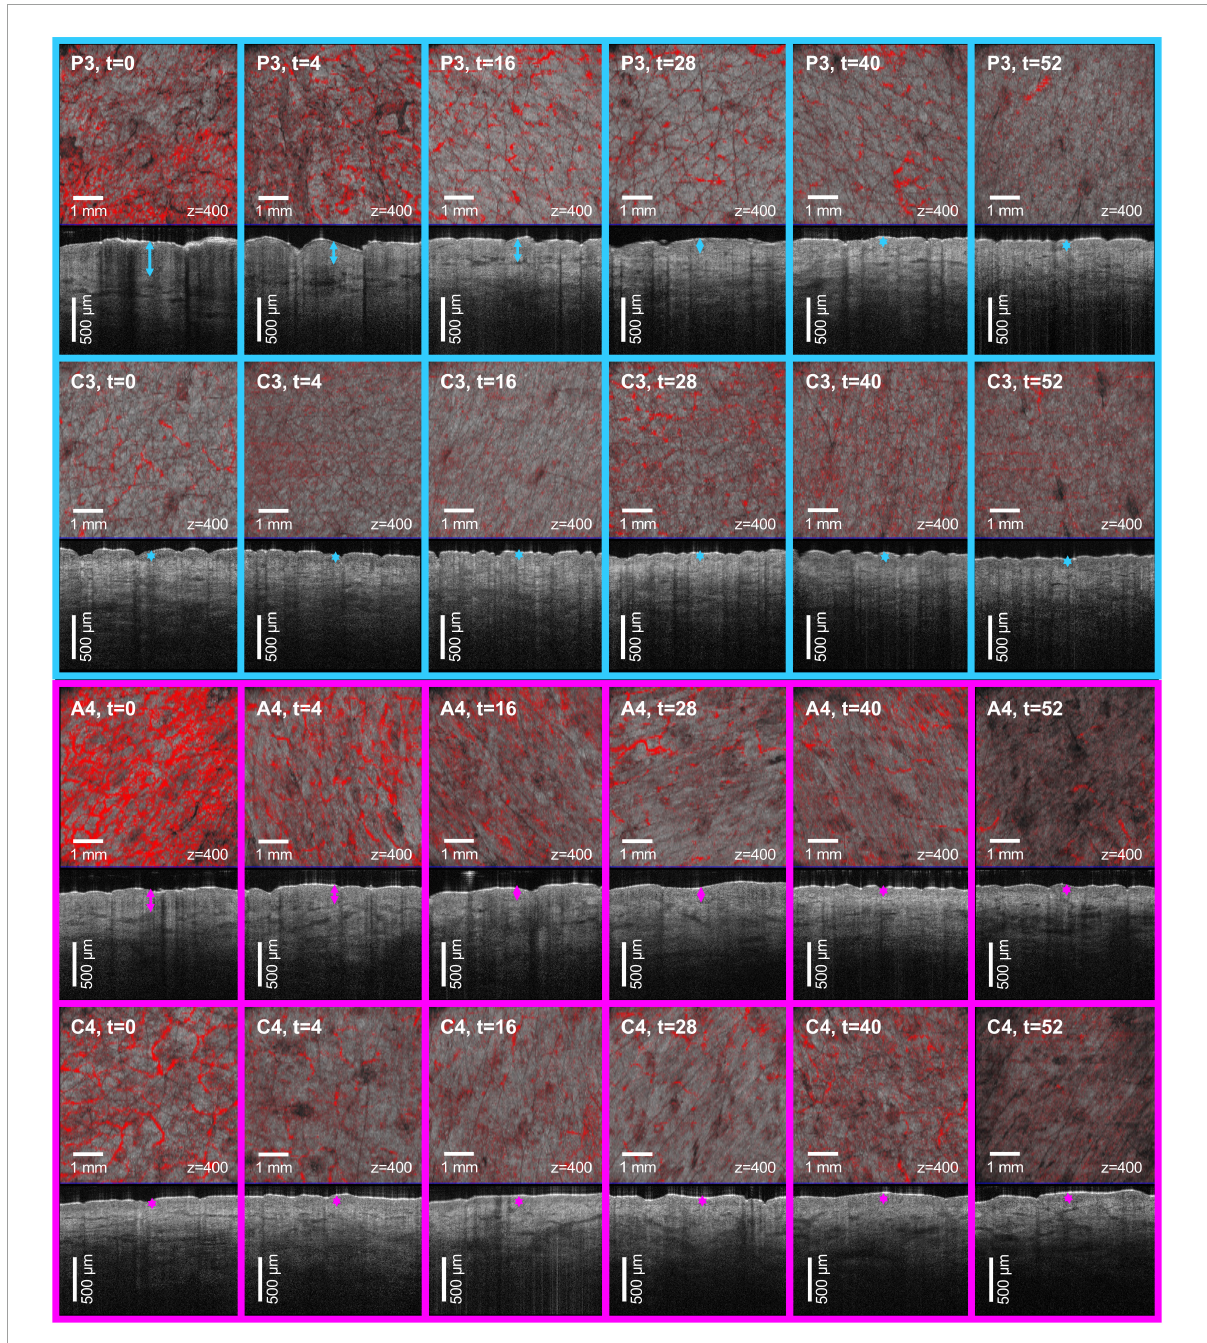
FIGURE3 Optical coherence tomography (OCT) guided monitoring of biologic therapy in psoriasis and atopic dermatitis. Patient 3 with psoriasis (P3) was treated with certolizumab (top) and patient 4 with atopic dermatitis (A4) was treated with dupilumab (bottom) for t = 52 weeks. The vertical B-scans and the corresponding en-face scans at 400 µ m depth were collected in the course of therapy. Hyperkeratotic psoriatic plaques led to a signal reduction at baseline. Under therapy a decrease of the epidermal thickening (arrows) and a normalization of the vascularization (red signal) were observed in psoriasis and atopic dermatitis. No significant changes were detected in the control sites (C3 and